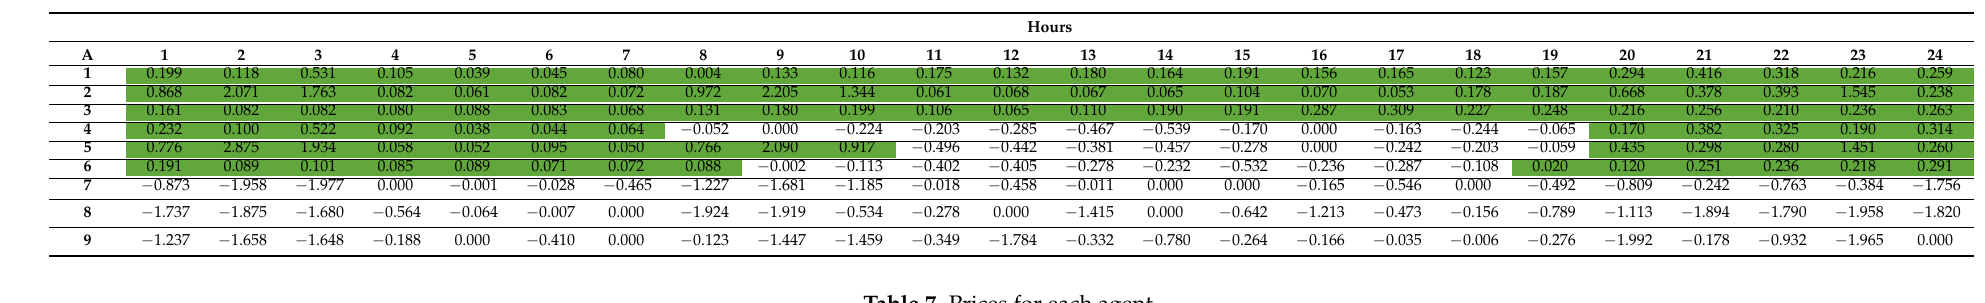
Table 7. Prices for each